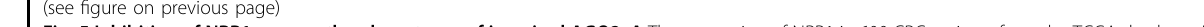
Fig. 5 Inhibition of NRP1 rescues the phenotypes of impaired AGO2. A The expression of NRP1 in 600 CRC patients from the TCGA database. N: 51, stage I: 105, stage II: 229, stage III: 179, stage IV: 88. B Kaplan – Meier plot of the OS of 279 CRC patients from the TCGA database. C IHC images of NRP1 in CRC primary tumor tissues (left) and metastatic foci (right); scale bars are 50 and 200 μ m. D Statistical analysis of H-scores of NRP1 in CRC primary tumor tissues and metastatic foci. E Statistical analysis of cell migration upon NRP1 knockdown in AGO2-KD CRC cells. F , G Statistical analysis of Transwell migration ( F ) and invasion ( G ) upon NRP1 knockdown in AGO2-KD CRC cells. H Metastatic foci from the mice are shown. I The number of liver metastatic nodules was analysed ( n = 6 per group). J Representative immunoblots of EMT markers. Data are shown as the mean ± SD. * p < 0.05, ** p < 0.01, *** p < 0.001, and **** p <